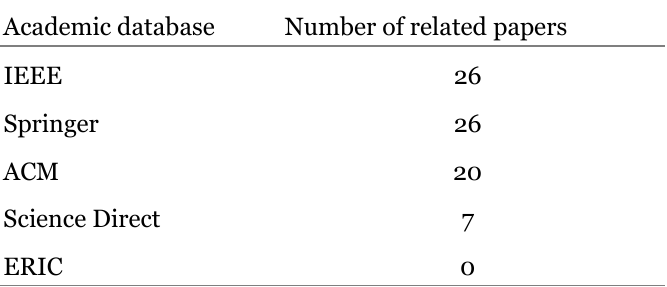
Distribution of Papers Found in Academic Databases